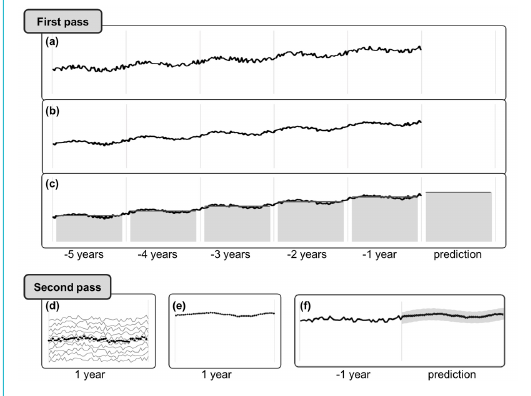
Figure 3: Schematic of the calculation of the expected number of deaths for a given age group in each week of the present year of mortality monitoring. In the first pass, observed numbers of deaths (a) are smoothed across the previous 5 calendar years (b) and the expected number for the current (prediction) year is estimated (c; years indicated by vertical bars). In the second pass, the weekly median numbers of deaths (dotted line) are calculated (d), then smoothed and calibrated to correspond to the expected level esti- mated in the first pass (e). Finally, a confidence band is deter- mined for the weekly numbers of expected deaths of the current (prediction) year (f).